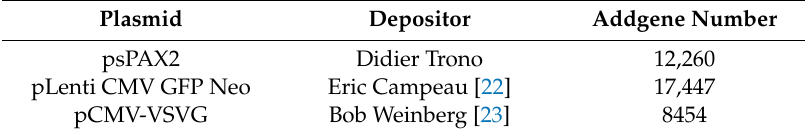
Table 1. Plasmids for lentiviral production (including depositor and addgene information). Plasmid Depositor Addgene Number psPAX2 Didier